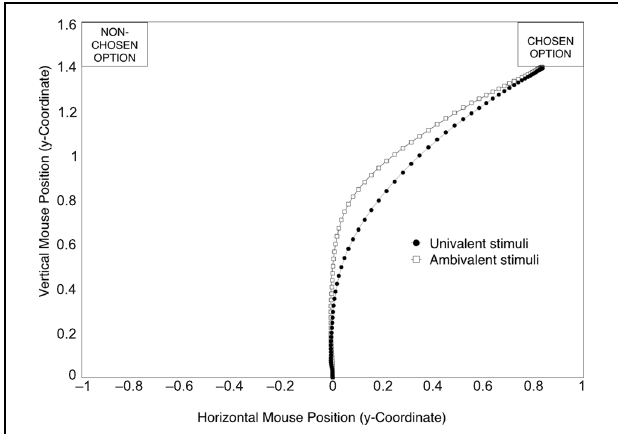
FIGURE 1 | Mean mouse trajectories in the evaluation task, averaged over ambivalent and univalent stimuli. In this figure, all trajectories are mapped rightward to allow